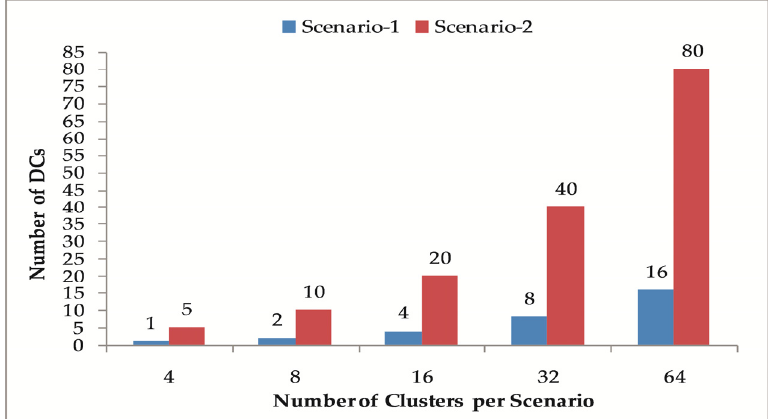
Figure 3. Required number of DCs for SM coverage.